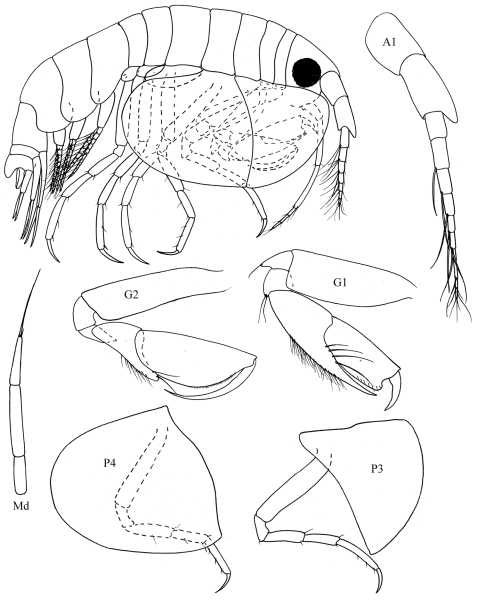

Cyproidea excavatasp. n., unknown sex